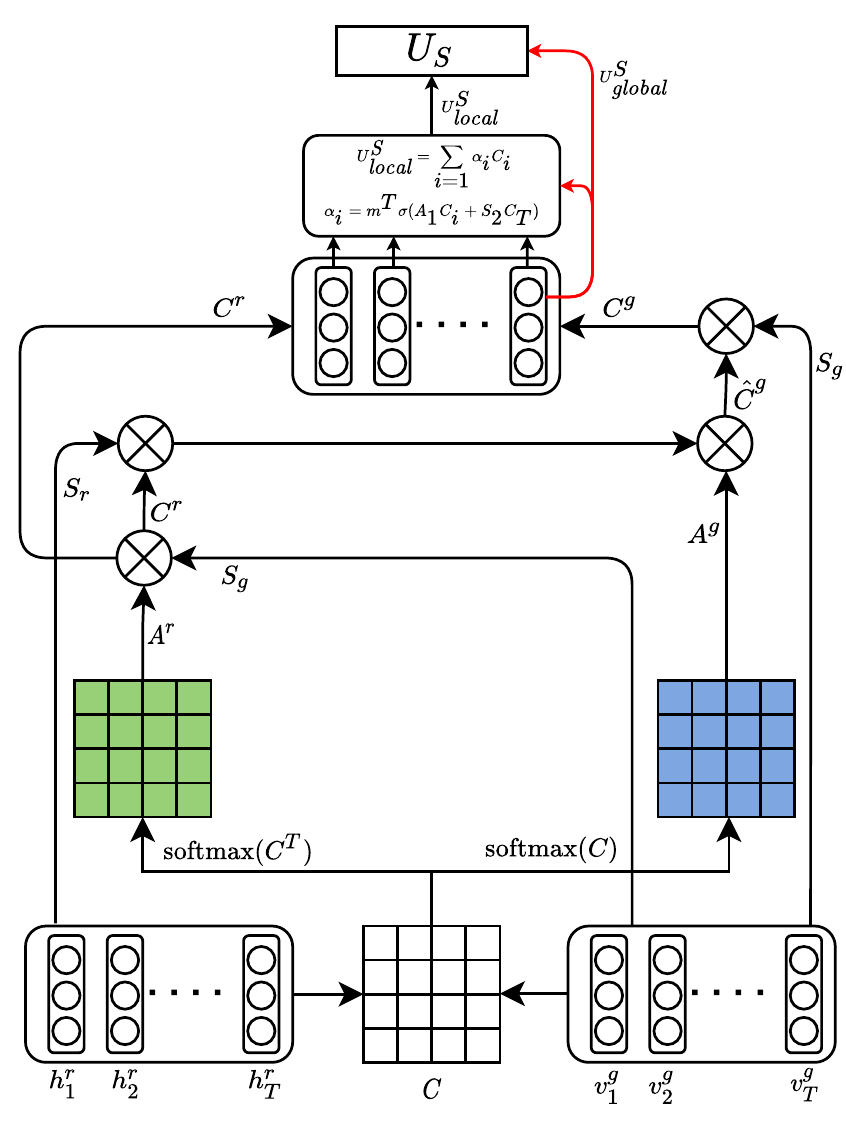
Figure 3. Details of the alternating co-attention